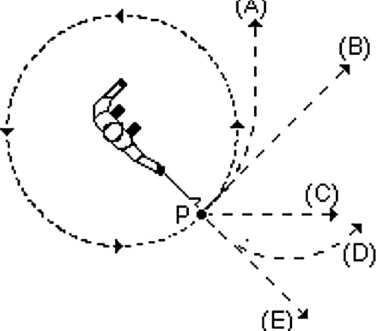
FIG. 1. Question 7 (Q.7) of the FCI [1]. [Question statement] A steel ball is attached to a string and is swung in a circular path in a horizontal plane as illustrated in the accompanying figure. At the point P indicated in the figure, the string suddenly breaks near the ball. If these events are observed from directly above as in the figure, which path would the ball most closely follow after the string breaks?